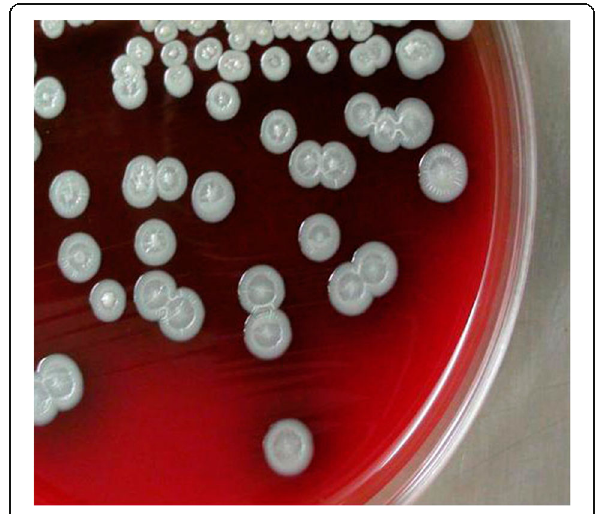
Fig. 2 Burkholderia pseudomallei colonies on blood agar: they are creamy white with concentric ring-like